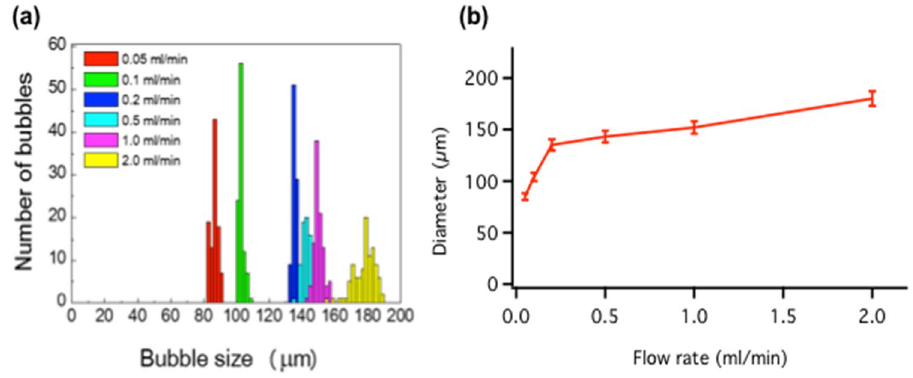
Figure 1. Polyelectrolyte microcapsule diameter control using a 7.2 × 10 − 2 M DTAB solution with varying flow